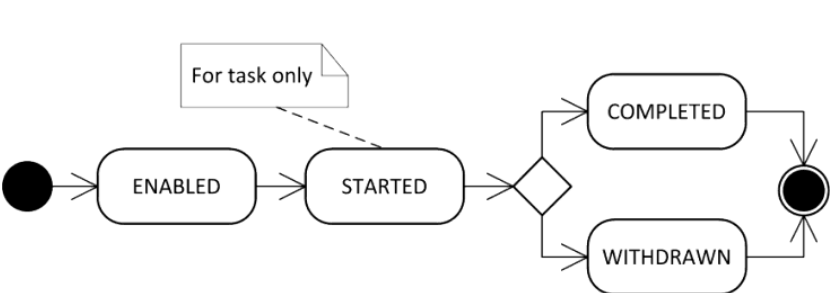
Figure 2. A UML (Unified Modeling Language) state diagram representing the lifecycle of a BPMN element supported by the Bimp simulator.